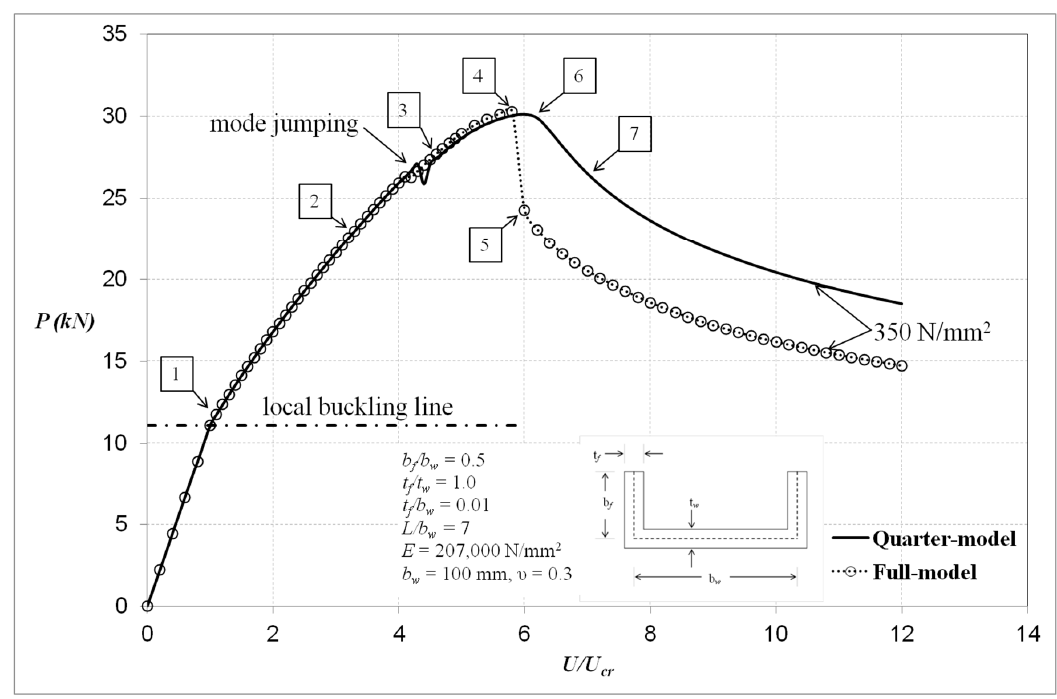
Figure 8. Load–end compression curves with yield stress level of 350 N/mm 2.